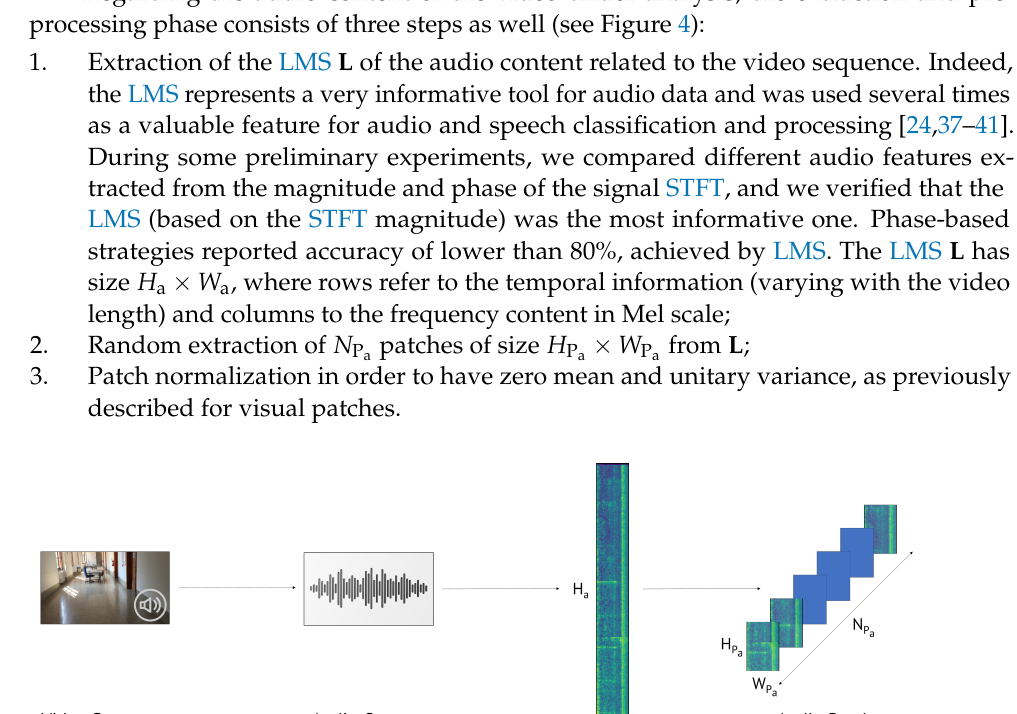
visual patches with size H P v